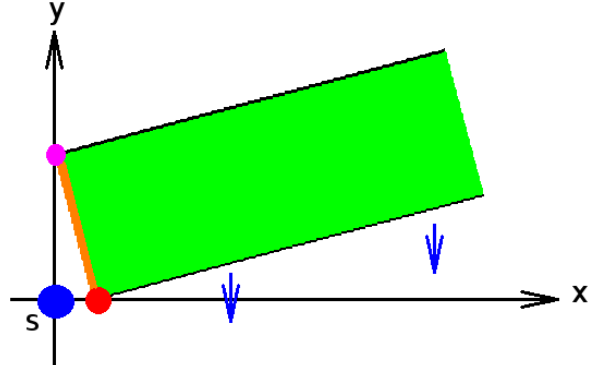
FIG. 14. Schematics of the horizontal scraper blade tilted by a (positive) angle about the longitudinal axis. The blue arrows show the movement of the blade. The beam comes out of the page at the blue point. The red point marks the lowest edge of the blade (parallel to the beam), the magenta point marks the innermost edge (parallel to the beam), and the orange line marks the innermost face.